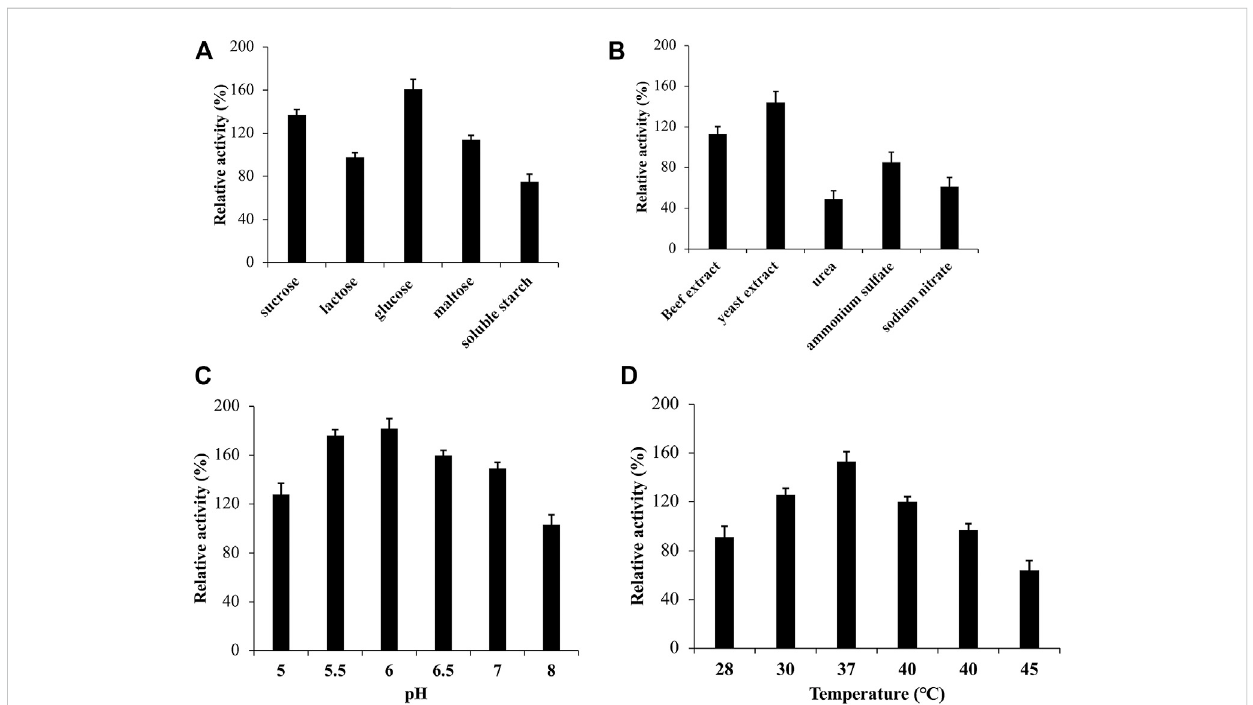
FIGURE 2 EffectofmediumandcultureconditionsontheCDAactivityof Bacilluscereus ZWT-08.Theeffectofcarbonsources (A) andnitrogensources (B) on the activity of CDA was compared at a concentration of 1% (m/V). The effect of pH (C) and temperature (D) on the CDA activity was studied in the optimized culture medium. The CDA activity determined in the basal fermentation medium at pH 7.0 ° C and 37 ° C with shaking at 180 rpm for 48 h was designated as 100% while others were expressed against this value.